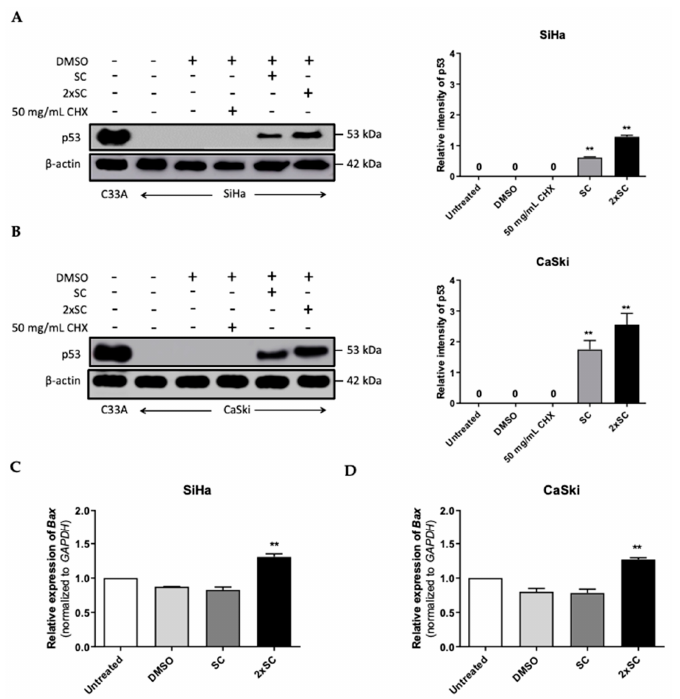
Figure 5. Androg restored p53 expression in HPV16-positive cervical cancer cell lines. ( A and B ) The expression of p53 protein in response to Androg treatment was measured by western blotting, as observed in two pairs of HPV16-positive cervical cancer sublines, SiHa (A) and CaSki (B). Column graphs represent the protein intensity of each set performed by ImageJ software. ( C and D ) The expression of pro-apoptotic gene, BAX, in response to Androg treatment was measured by qRT-PCR. In each sample, the relative expression of BAX was determined after normalization to the GAPDH expression level. ** p < 0.01.